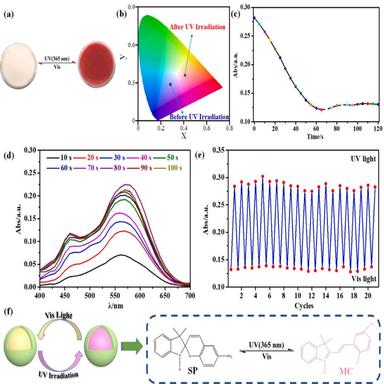
(a) Optical images of RP-MicroPCMs before and after UV irradiation; (b) the color distribution of the RP-MicroPCMs before and after UV irradiation in the (x, y) chromaticity diagram (standard CIE 1931); (c) absorbance of RP-MicroPCMs versus visible irradiation time after UV irradiation; (d) variation in absorbance of RP-MicroPCMs after irradiation at 365 nm for different time; (e)photodegradation-resistance of RP-MicroPCMs upon alternative UV and visible light irradiation; (f) schematic of photochromic mech